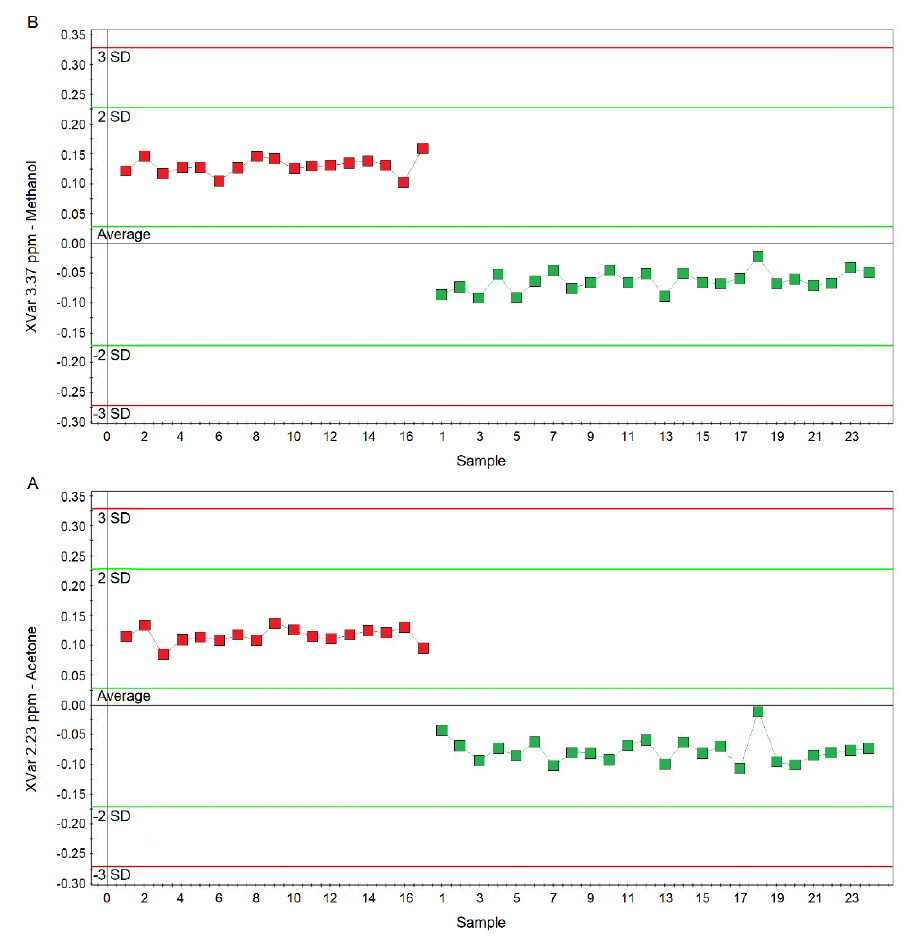
Figure 7. Plots of the NMR variables values for two of the four statistically significant metabolites contributing to the separation of the nPCD and nCF / nPCD groups. ( A ) Acetone / acetoin (XVar 2.23 ppm). ( B ) Methanol (XVar 3.37 ppm). Selected bucket variations are scaled to the total spectral area. nCF / nPCD patients are identified by red squares, while green squares identify PCD patients. Numbers on the x-axis refer to EBC samples used for the analysis; the y-axis reports the bucket variation. In nFC / nPCD, the levels of acetone / acetoin and methanol are increased by 21% and 18%, respectively, with respect to PCD (see